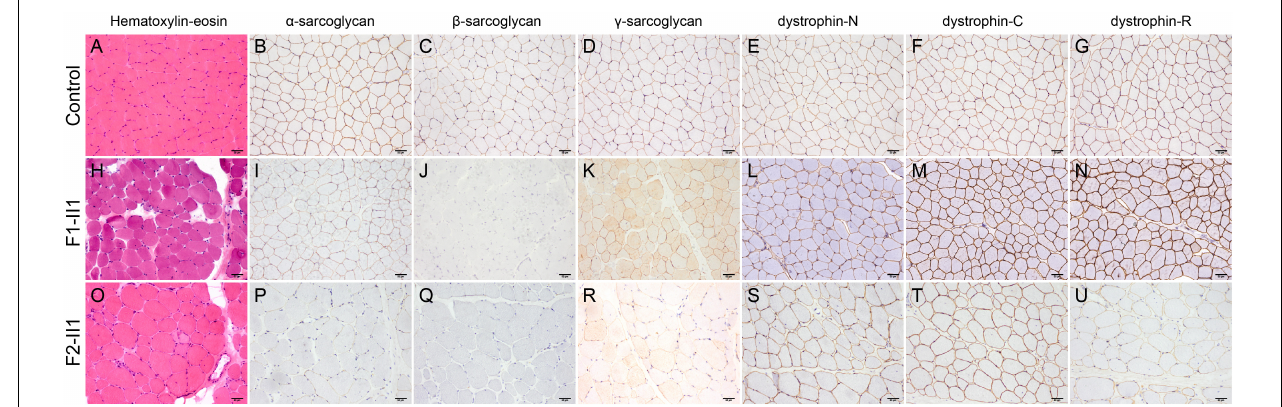
FIGURE 2 | Pathologic features of patients with beta-sarcoglycanopathy. (H,O) Hematoxylin-eosin staining showing a muscular dystrophic pattern in patients F1-II1 and F2-II1. (A–G) A normal control showing positive expression of sarcoglycans and dystrophin. (H–N) Patient F1-II1 showing a mild reduction of α -sarcoglycan, complete deficiency of β -sarcoglycan, a partial reduction of γ -sarcoglycan, a very slight reduction of dystrophin-N, and positive expression of dystrophin-C and dystrophin-R. (O–U) Patient F2-II1 showing a severe reduction of α -sarcoglycan, absent expression of β -sarcoglycan, a partial reduction of γ -sarcoglycan, a very slight reduction of dystrophin-N, positive expression of dystrophin-C, and a partial reduction of dystrophin-R. 200 × magnification. TABLE 1 | Pathogenic SGCB variants identified in our patients with beta-sarcoglycanopathy. Patient Intron/Exon Genomic variant Parental cDNA variant RNA variant Protein variant Evidence of number derivation